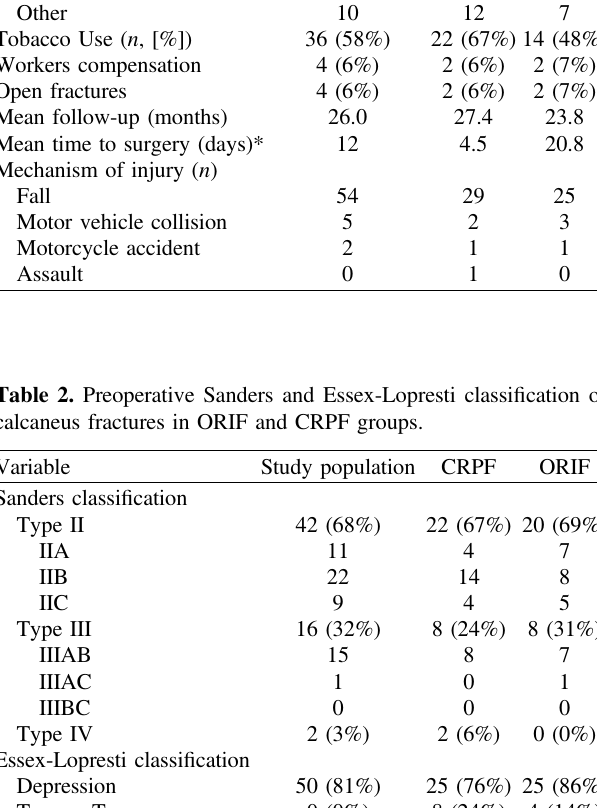
measured Bohler ’ s angle was 25.4 degrees (range: (cid:1) 5.0 to 41.9 degrees) for the ORIF group and 25.0 degrees (range: (cid:1)